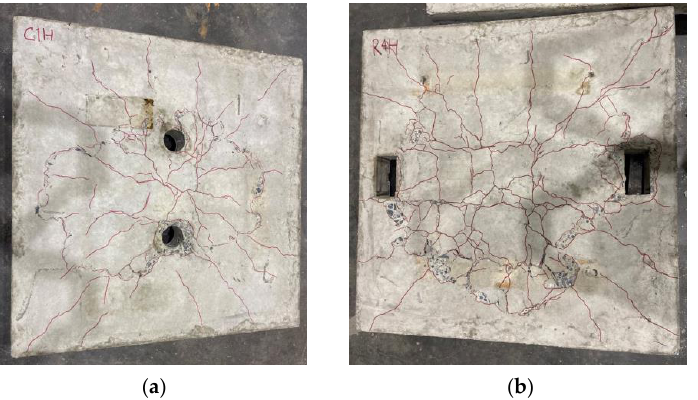
Figure 9. Crack patterns at failure for group 1 (Actual photos). ( a ) Specimen 2C1H; ( b ) Specimen